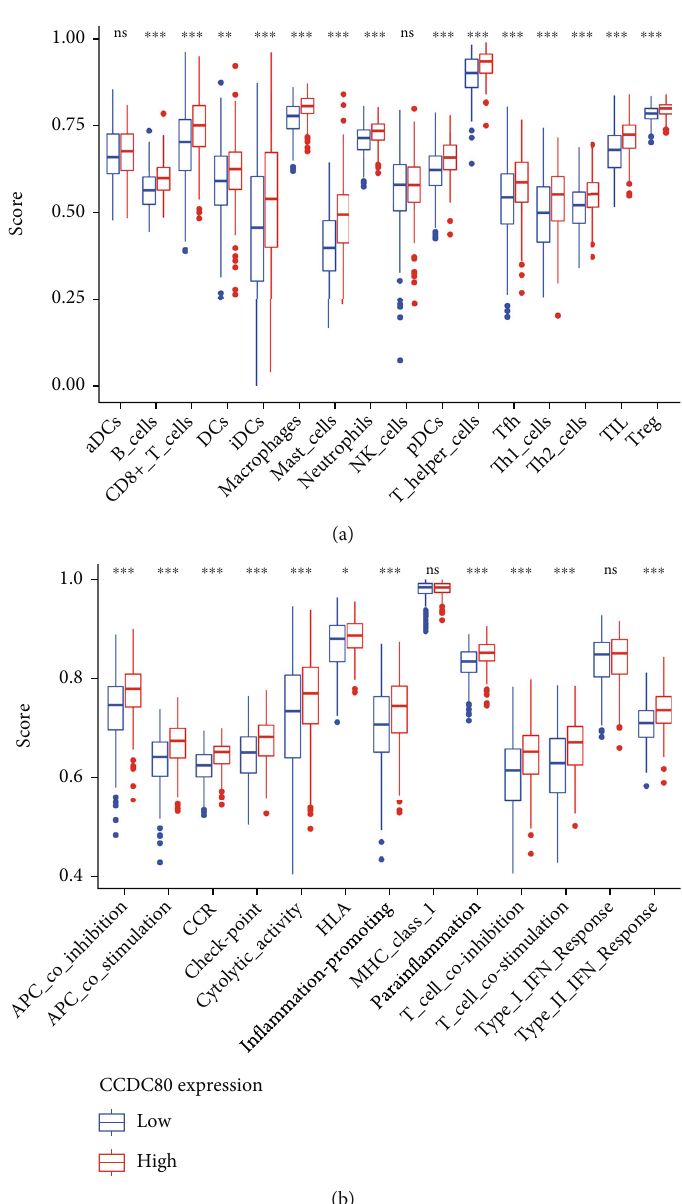
Figure 6: The boxplots visualizing the single-sample gene set enrichment analysis (ssGSEA) in high- and low- CCDC80 expression group in OVCA based on immunocyte-related gene sets (a) and immune function-related gene sets (b) ( ∗∗∗ , P < 0 : 0001 ; ∗∗ , P < 0 : 001 ; ∗ , P < 0 : 05 ; ns, P ≥ 0 : 05